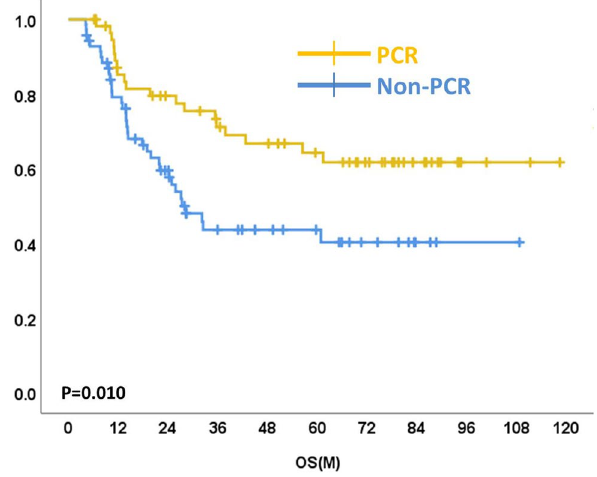
Figure 2. Overall survival curves of esophageal cancer patients with pCR and